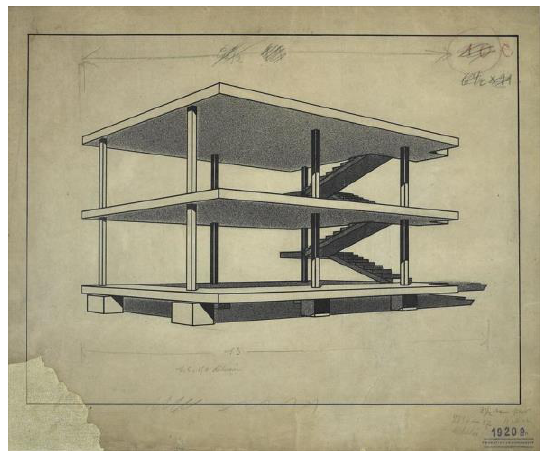
Figure 3. Domino house by Le Corbusier